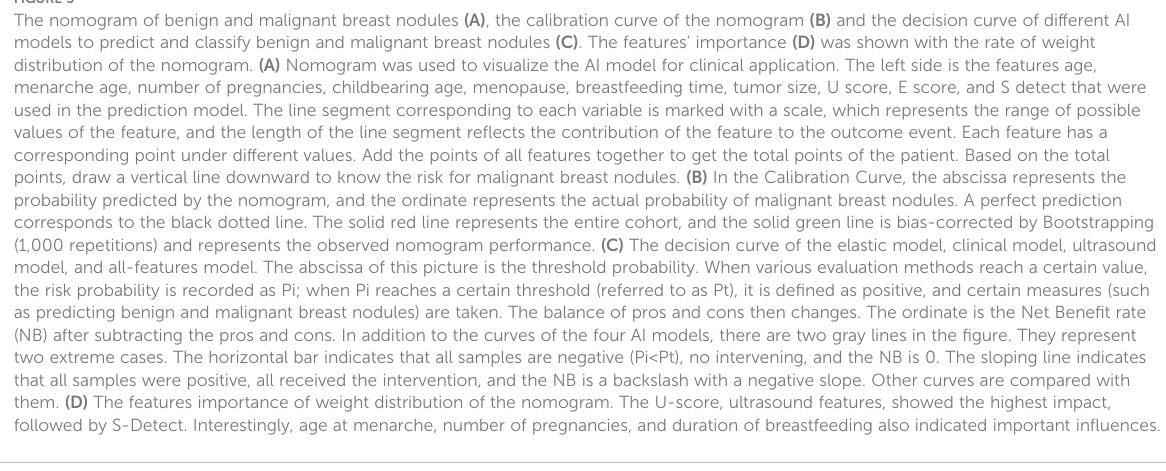
FIGURE 3 The nomogram of benign and malignant breast nodules (A) , the calibration curve of the nomogram (B) and the decision curve of different AI models to predict and classify benign and malignant breast nodules (C) . The features ’ importance (D) was shown with the rate of weight distribution of the nomogram. (A) Nomogram was used to visualize the AI model for clinical application. The left side is the features age, menarche age, number of pregnancies, childbearing age, menopause, breastfeeding time, tumor size, U score, E score, and S detect that were used in the prediction model. The line segment corresponding to each variable is marked with a scale, which represents the range of possible values of the feature, and the length of the line segment re fl ects the contribution of the feature to the outcome event. Each feature has a corresponding point under different values. Add the points of all features together to get the total points of the patient. Based on the total points, draw a vertical line downward to know the risk for malignant breast nodules. (B) In the Calibration Curve, the abscissa represents the probability predicted by the nomogram, and the ordinate represents the actual probability of malignant breast nodules. A perfect prediction corresponds to the black dotted line. The solid red line represents the entire cohort, and the solid green line is bias-corrected by Bootstrapping (1,000 repetitions) and represents the observed nomogram performance. (C) The decision curve of the elastic model, clinical model, ultrasound model, and all-features model. The abscissa of this picture is the threshold probability. When various evaluation methods reach a certain value, the risk probability is recorded as Pi; when Pi reaches a certain threshold (referred to as Pt), it is de fi ned as positive, and certain measures (such as predicting benign and malignant breast nodules) are taken. The balance of pros and cons then changes. The ordinate is the Net Bene fi t rate (NB) after subtracting the pros and cons. In addition to the curves of the four AI models, there are two gray lines in the fi gure. They represent two extreme cases. The horizontal bar indicates that all samples are negative (Pi<Pt), no intervening, and the NB is 0. The sloping line indicates that all samples were positive, all received the intervention, and the NB is a backslash with a negative slope. Other curves are compared with them. (D) The features importance of weight distribution of the nomogram. The U-score, ultrasound features, showed the highest impact, followed by S-Detect. Interestingly, age at menarche, number of pregnancies, and duration of breastfeeding also indicated important in fl